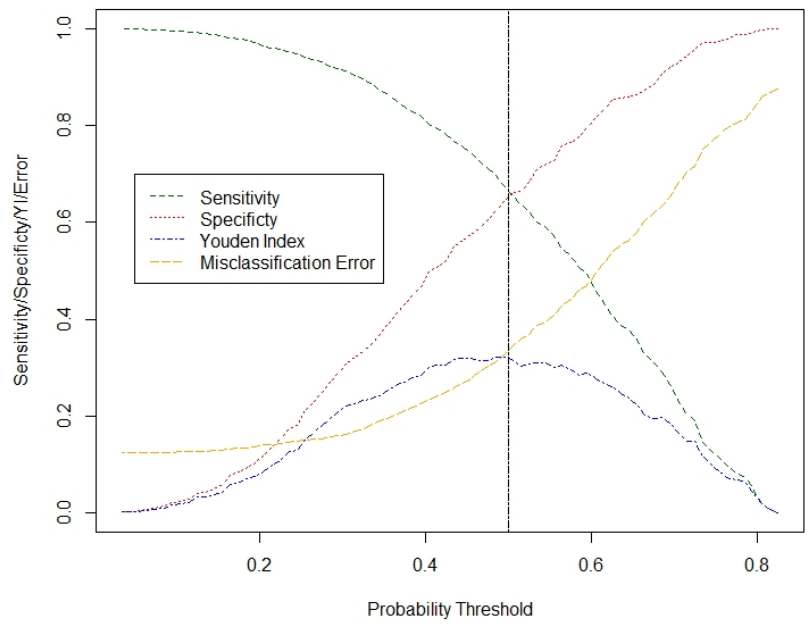
Figure 3. Diagram of the sensitivity, specificity, Youden index, and misclassification error for the MBFS model across different prediction probability thresholds, based on the test dataset ( n = 5210).